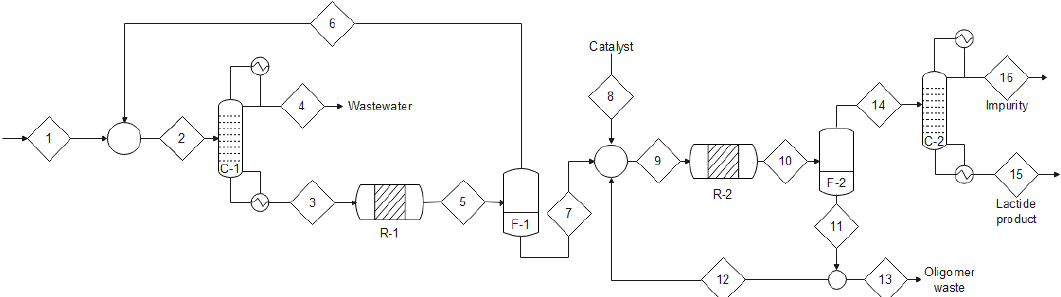
Figure 7. Conventional two-step lactide synthesis process (reprinted with permission [48], Copyright 2019 American Chemical Society): (1) lactic acid stream, (2) lactic acid + reflux mixed stream, (3) dehydrated lactic acid stream, (4) wastewater, (5) dehydrated lactic acid stream, (6) lactic acid recovery, (7) R-1 liquid phase, (8) catalyst feed stream, (9) lactic acid + catalyst mixed stream, (10) oligomers stream, (11) unreacted oligomers stream, (12) unreacted oligomer recovery, (13) high molar mass oligomers, (14) crude lactide stream, (15) purified lactide stream, (16) unpurified lactide stream, (C-1, C-2) distillation columns, (R-1, R-2) polycondensation and depolymerization reactors, respectively, (F-1, F-2) heating